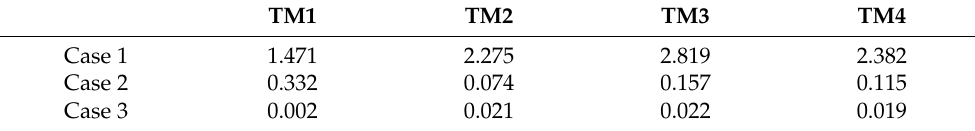
Figure 10. NAPE of estimated girder axial force for TM4. Table 3. NMAPE of estimated girder axial force for each TM and